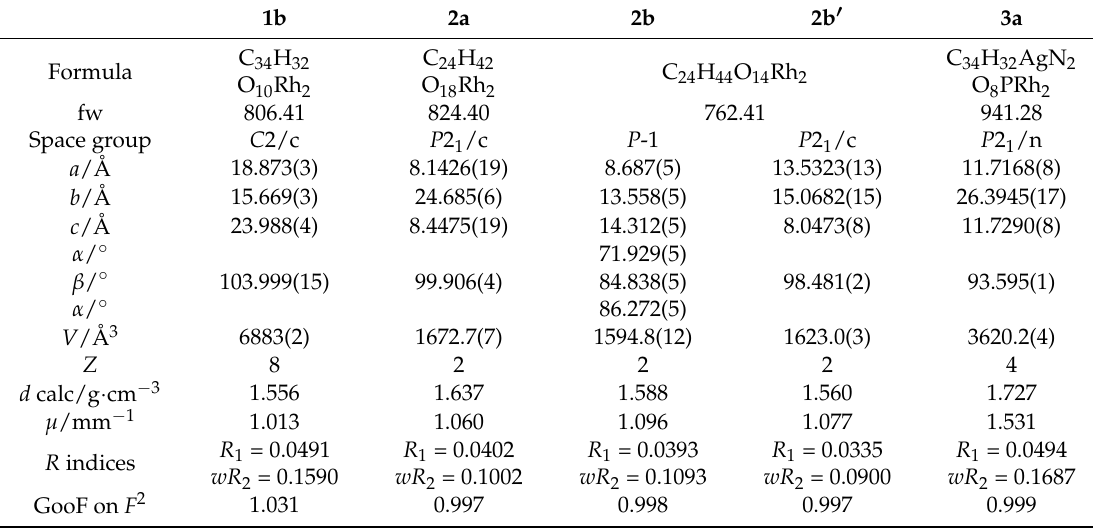
Table 1. Crystal and refinement data for 1 – 2 and 3a